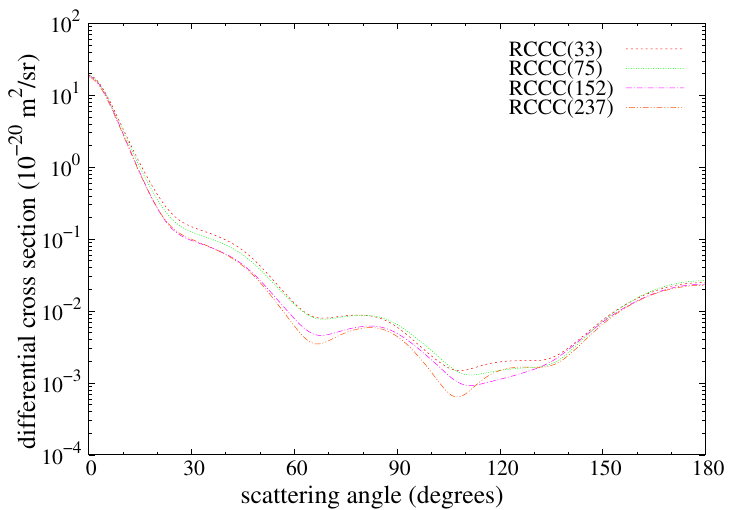
Figure 13. Convergence of the RCCC DCS with number of states. Only shown for the 5 p 2 3 P 0 3 P ○ 1 dipole-allowed transition at 20